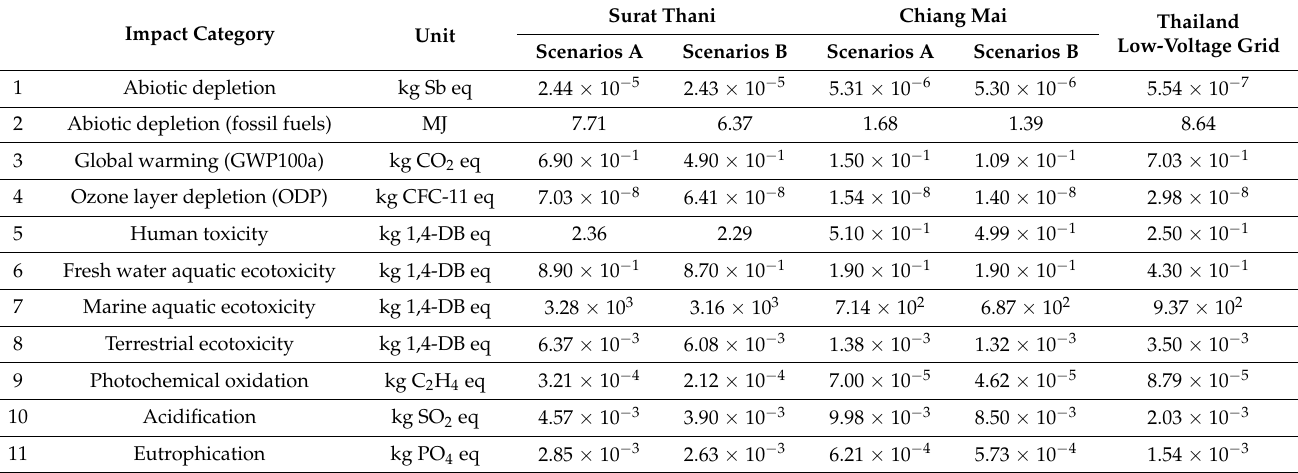
Table 6. Scenarios A and B compared with Thailand low-voltage grid impacts (per